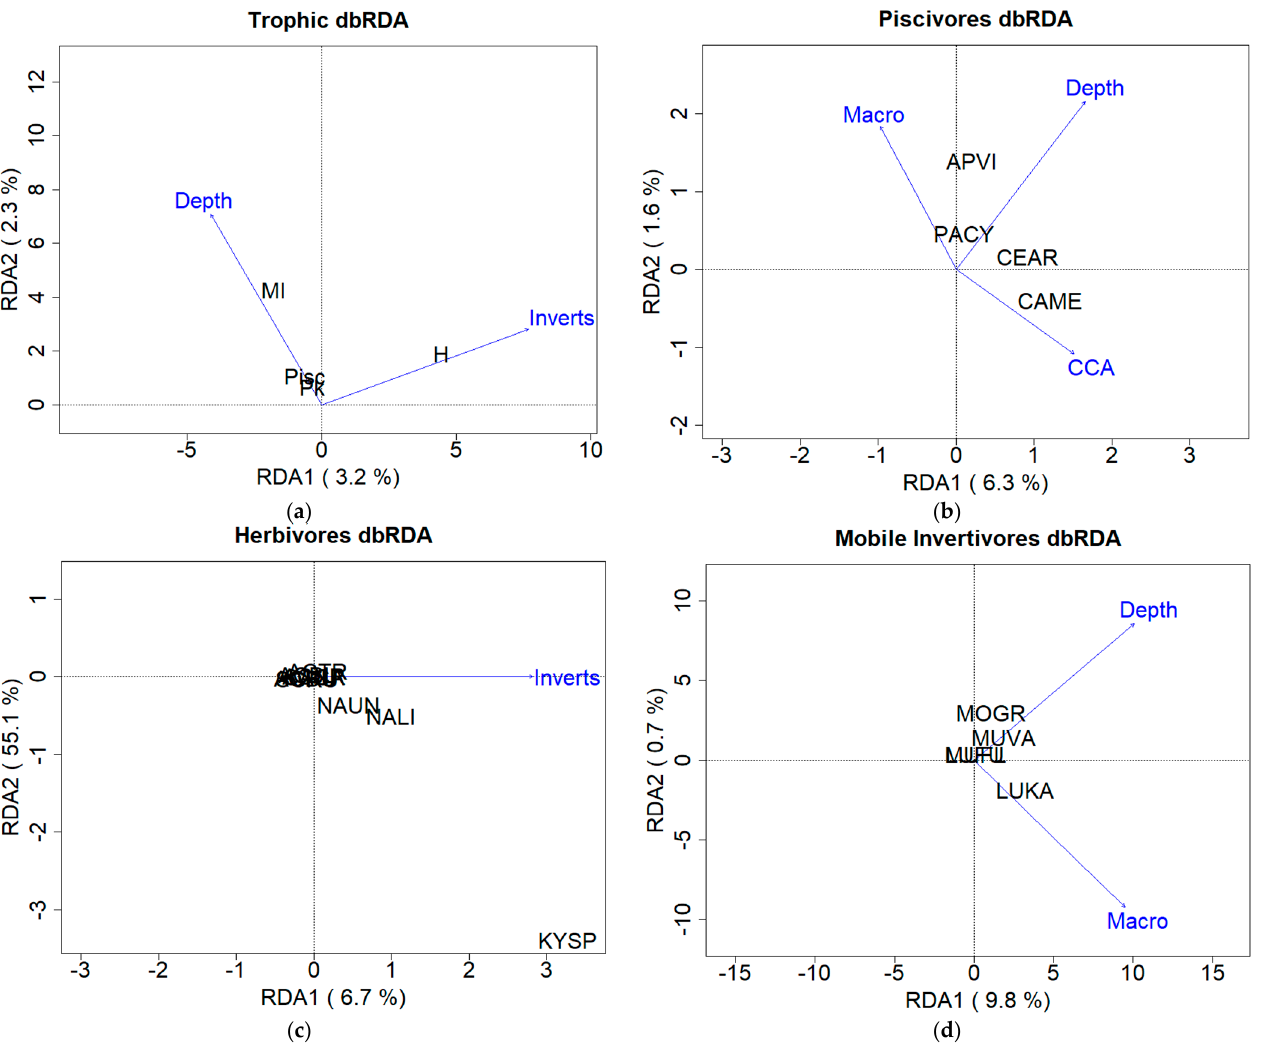
Figure 6. Distanced-based redundancy analyses (dbRDA) plots of ( a ) trophic level correlations, ( b ) piscivore correlations, ( c ) herbivore correlations, and ( d ) mobile invertivore correlations with benthic substrate components.